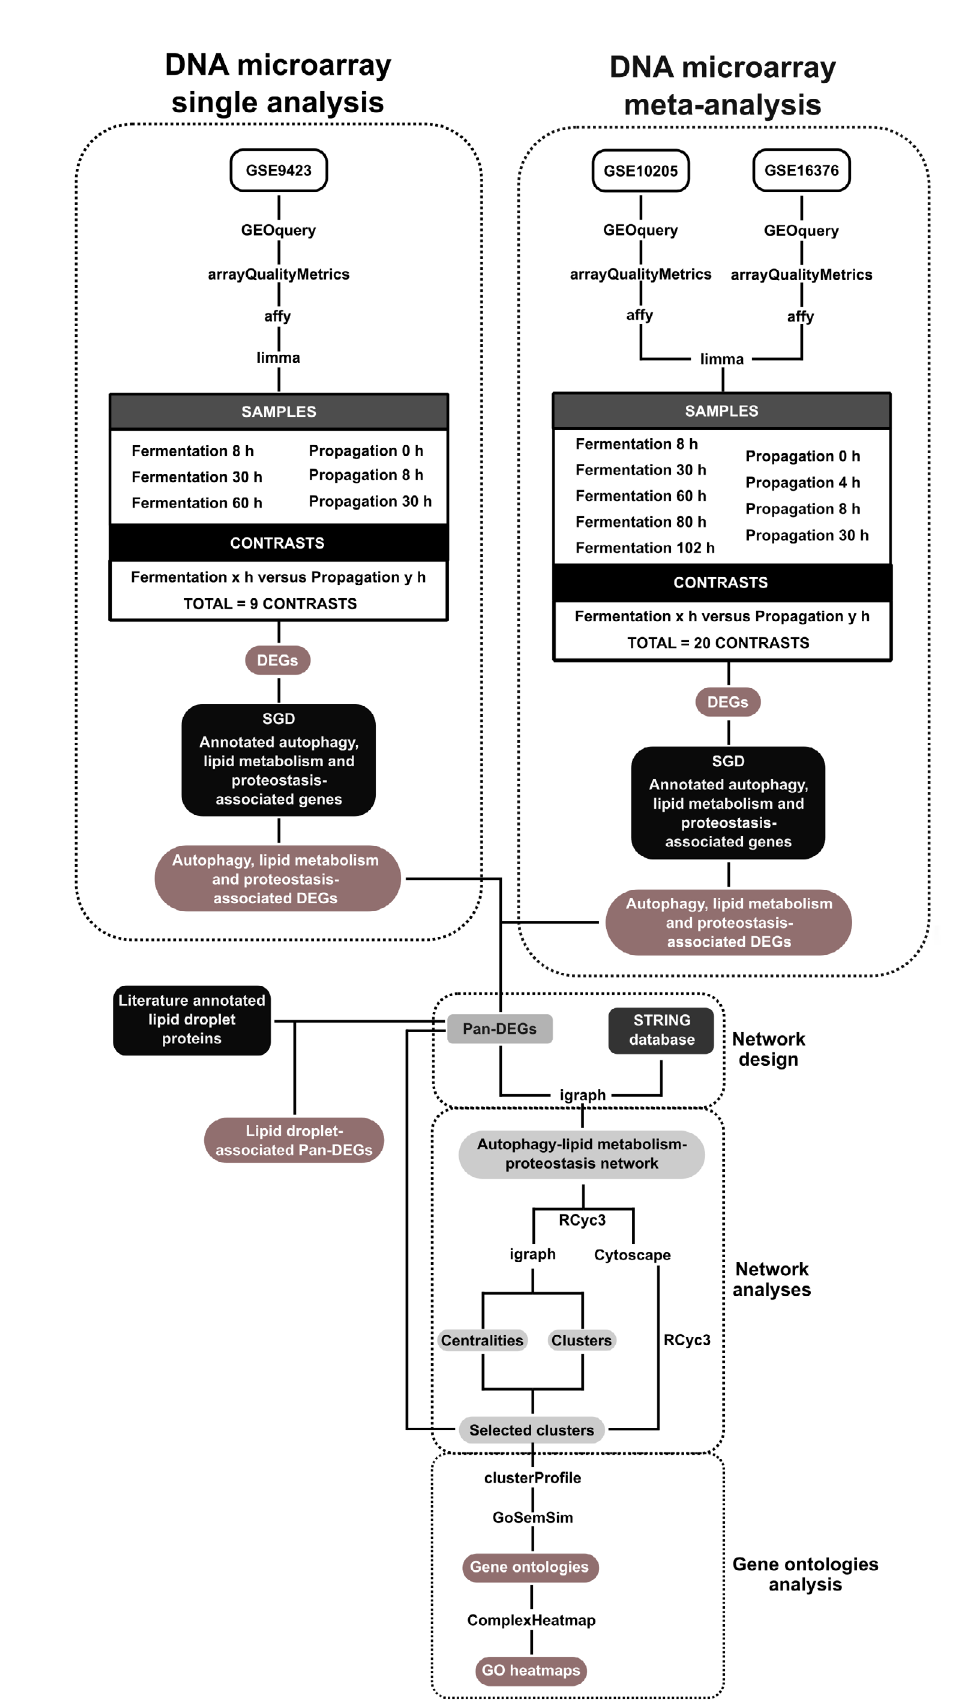
Figure 1 - Experimental design used in DNA microarray single- and meta-analyses and systems biology analysis. DEGs: differentially expressed genes; GO: Gene Ontologies; SGD: Saccharomyces Genome